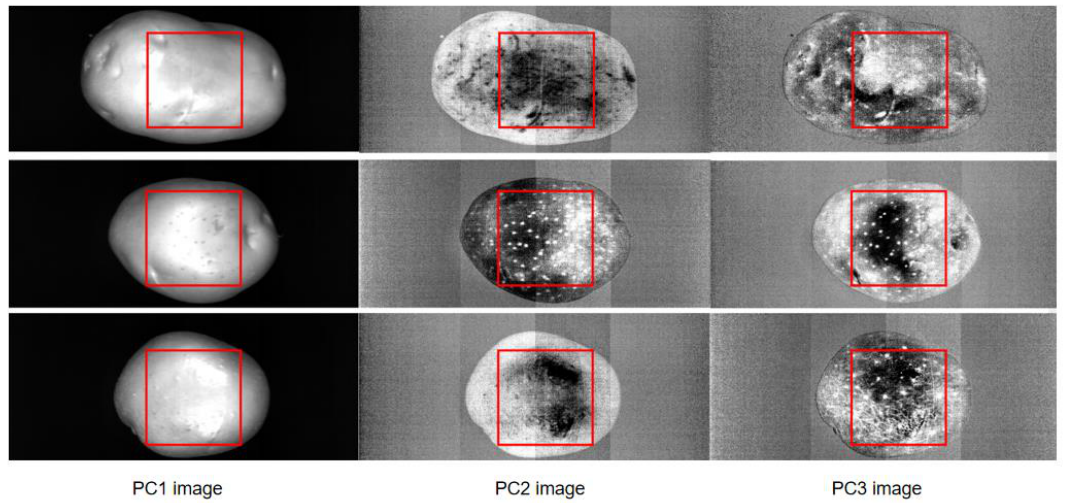
Figure 2. PC images extracted from the hyperspectral images of potato samples.